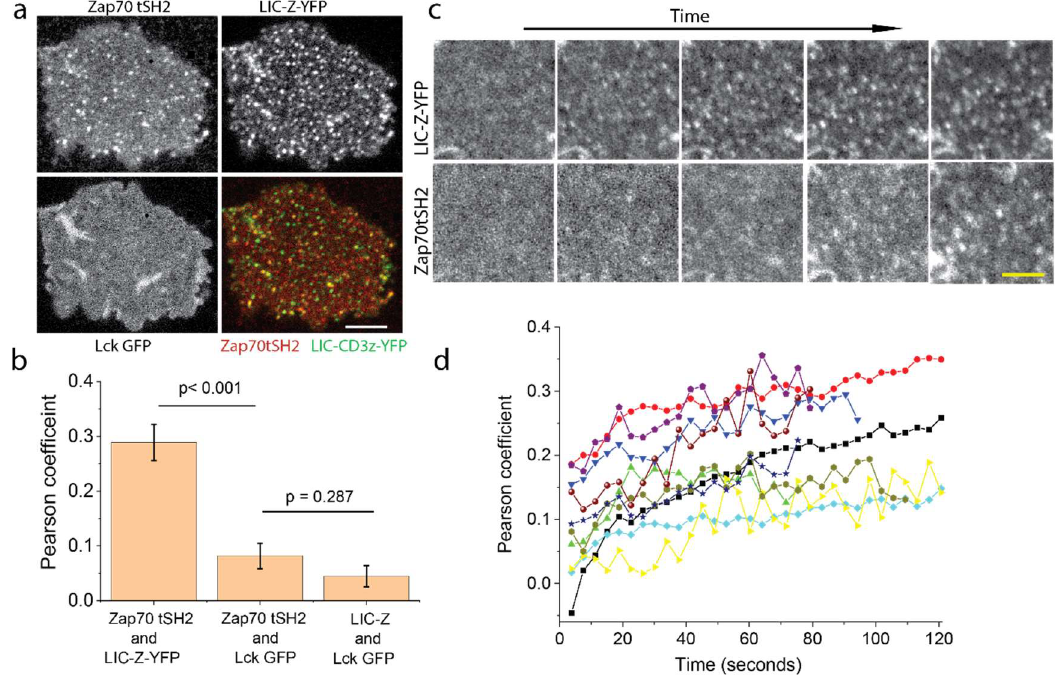
Figure 6. Zap70 tSH2 is recruited to LIC-Z-YFP clusters in reconstituted COS-7. COS-7 cells were reconstituted to co-express LIC-Z-YFP, mCherry-tagged Zap70 tSH2 and wild-type Lck GFP. ( a , b ) Representative images of Zap70 tSH2, LIC-Z-YFP and Lck GFP colocalization in COS-7 cells immediately fixed after 2 min irradiation with blue light ( a ) and corresponding Pearson coefficient analysis ( b ); Scale bar = 10 µm. In ( b ), the third column is Pearson coefficient values between LIC-Z and Lck GFP channel in COS-7 cells expressing only these two constructs. Data are mean and standard error of n = 20 cells. * p < 0.05, (one-way ANOVA with Fisher LSD post hoc test). ( c , d ). Representative images of the dynamic recruitment of Zap70 tSH2 to newly formed LIC-Z-YFP clusters in live COS-7 cells ( c ) and frame-by-frame Pearson coefficient values ( d ) between Zap70 tSH2 and LIC-Z-YFP channel; Scale bar = 3 µm. Each trace is one cell.